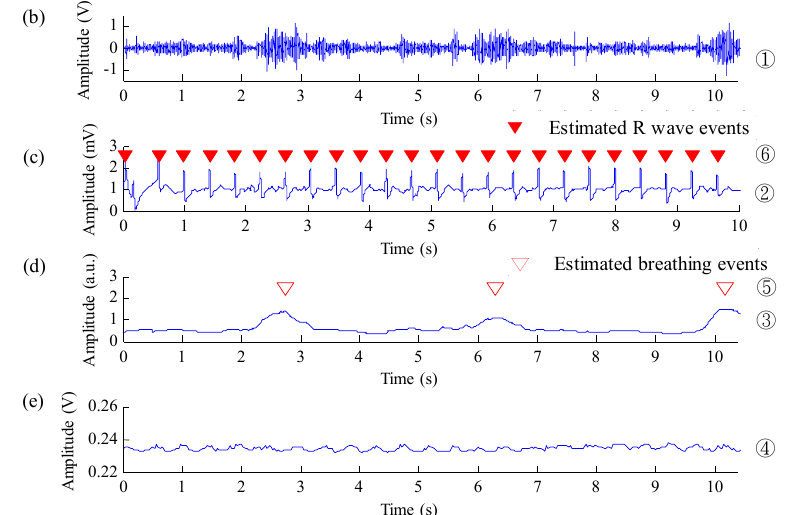
Figure 6. ( a ) Procedure of the multiparameter analysis algorithm. This analysis algorithm processes physiological signals and outputs data, including: ( b ) sound signal, ( c ) ECG signal and R-wave events, ( d ) FD value of sound signal and breathing events, and ( e ) PPG signal.